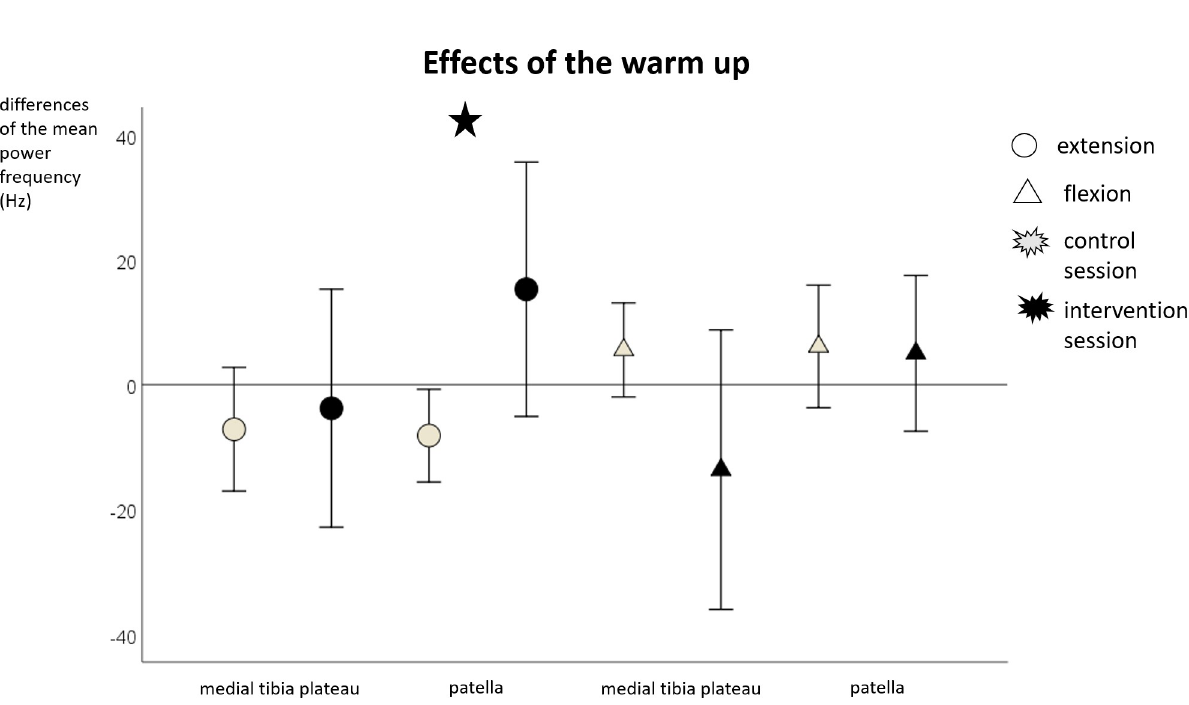
Fig 4. Mean and 95% confidence interval values of the pre-post differences of the median power frequency during extension and flexion for the warm-up. The asterisks marks significant differences between the control and intervention sessions.